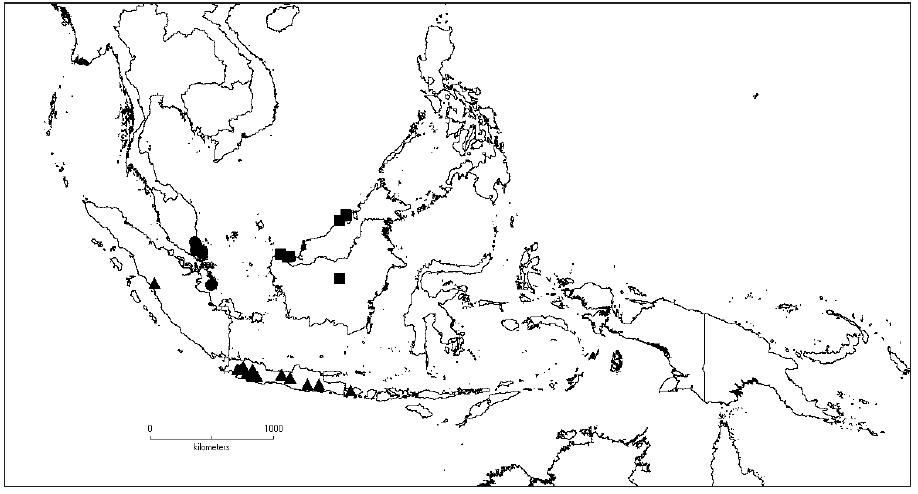
Map 19. Distribution of D. johorensis ( ● ), D. latifolia ( ■ ) and D. leprosa ( ▲ ).